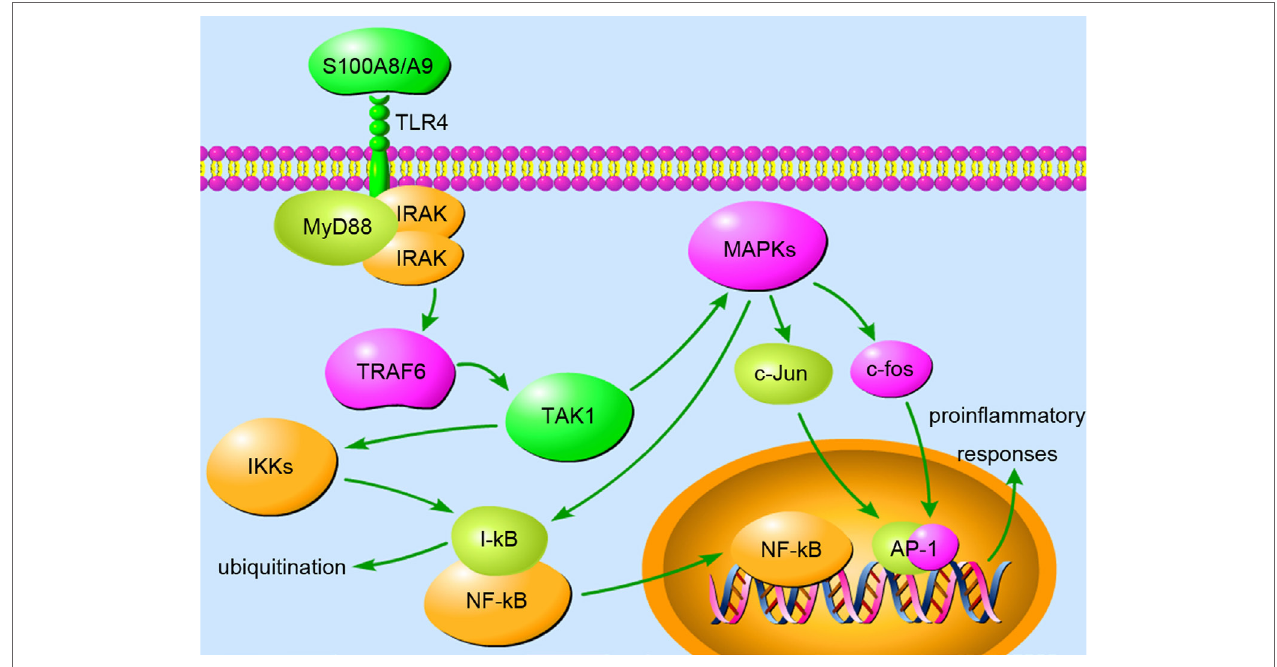
FiGURe 1 | The binding of S100A8/A9 to toll-like receptor (TLR) 4 triggers the MyD88-dependent pathway, appearing to play a vital role in inflammation. MyD88 recruits and activates IRAKs and TRAF6, which activates TAK1 via a TAB-mediated method. The activation of TAK1 facilitates the phosphorylation and activation of IKK and MAPK. Activated IKK phosphorylates and ubiquitinates I- κ B, resulting in the liberation of NF- κ B from inhibition. NF- κ B translocates to the nucleus and induces the expression of pro-inflammatory cytokines. MAPKs, including p38, JNK, and ERK, have been demonstrated to activate c-Jun and c-fos, which translocate to the nucleus and form heterodimer AP-1, another transcription factor. Moreover, MAPK pathways are also involved in S100A8/A9-induced NF- κ B activation during inflammation. The upregulated expression of pro-inflammatory genes amplifies the inflammatory response and severely destructs tissues in inflammation-associated